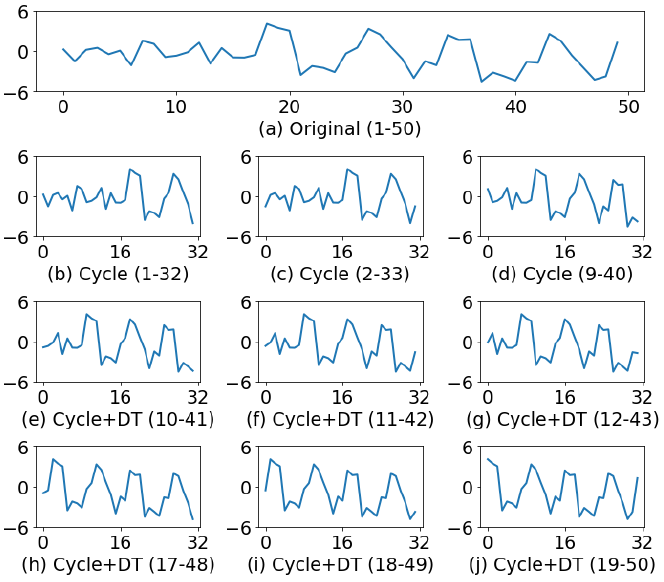
Figure 11. Application of online